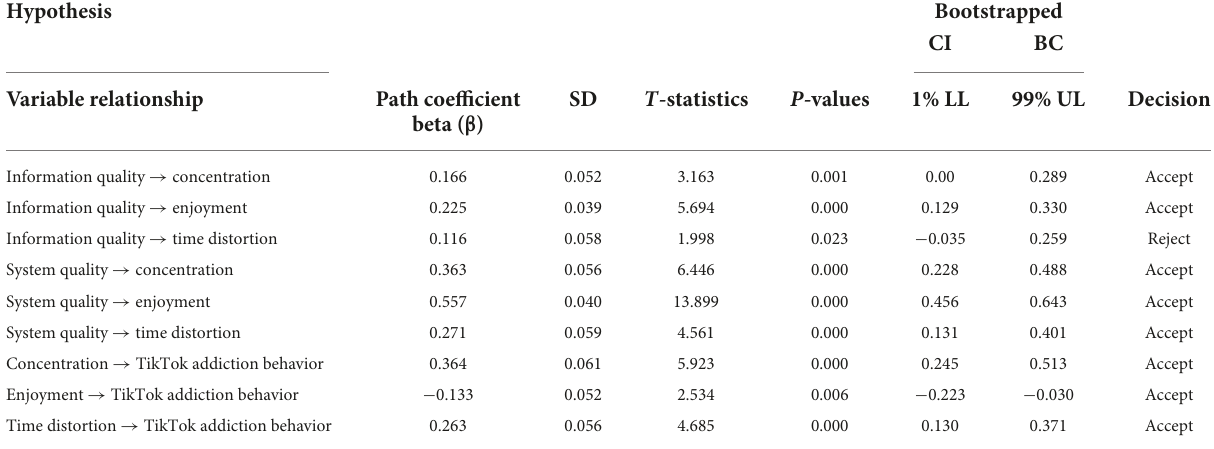
TABLE 5 Direct effect